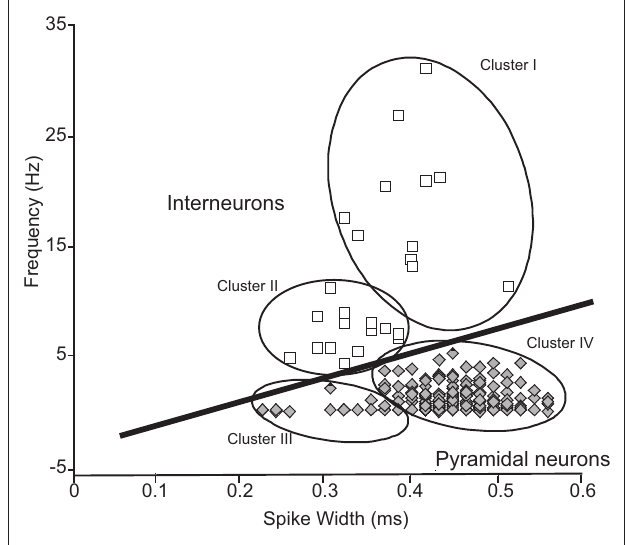
Figure 2 | Classification of HF neurons on the basis of physiological parameters in extracellular neuronal recordings. A linear cut-off method in firing rate–spike width space (Wiebe and Stäubli, 2001) to classify of pyramidal neurons and interneurons. HF neurons were initially grouped into the four clusters (I–IV) according to the cluster analysis. These four clusters were further grouped into two clusters (pyramidal neurons and interneurons) by the linear cut-off method. The population of pyramidal neurons was statistically well separated in the two-dimensional space [ F (2,417) = 357, P < 0.0001 by two-way ANOVA]. Note that the distribution pattern and characteristics of waveforms of the pyramidal neuron and interneurons are comparable to those in rats (Jung et al., 1994; Csicsvari et al., 1999; Wiebe and